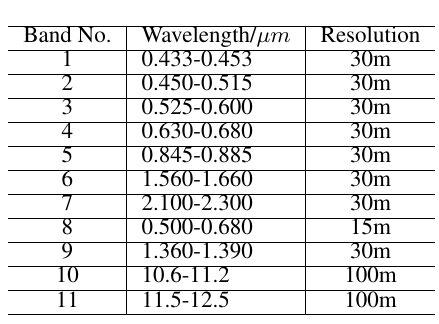
Table 1. Configuration of OLI/TIRS bands aboard